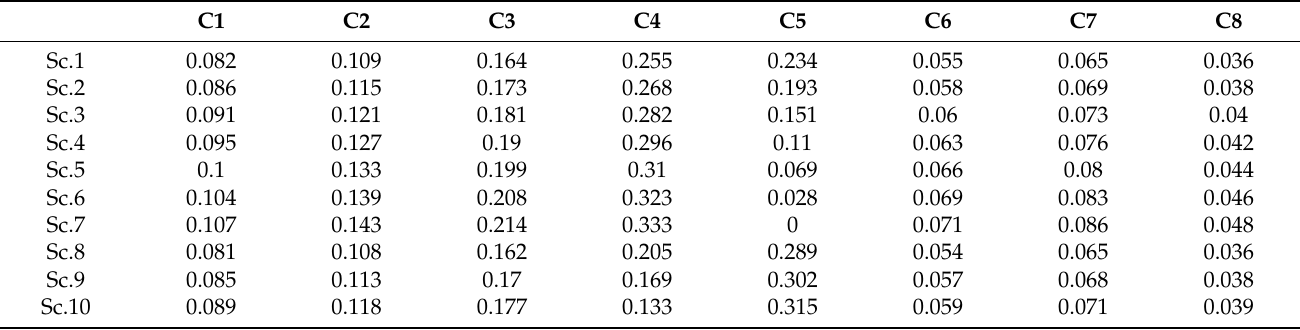
Table 10. Criteria weights in sensitivity analysis